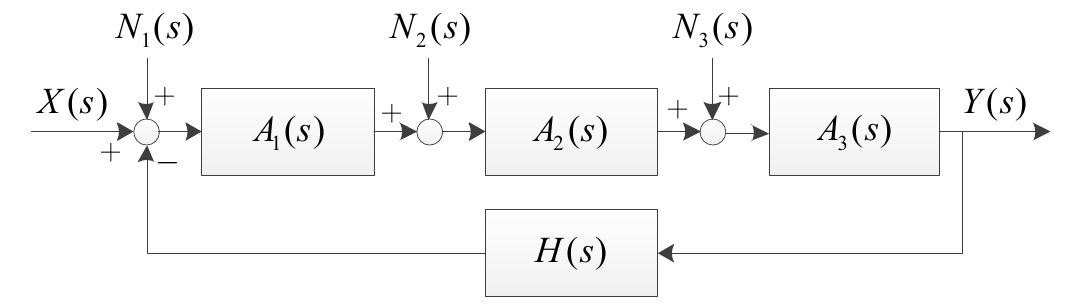
Figure 7. The noise model of the power amplifier.